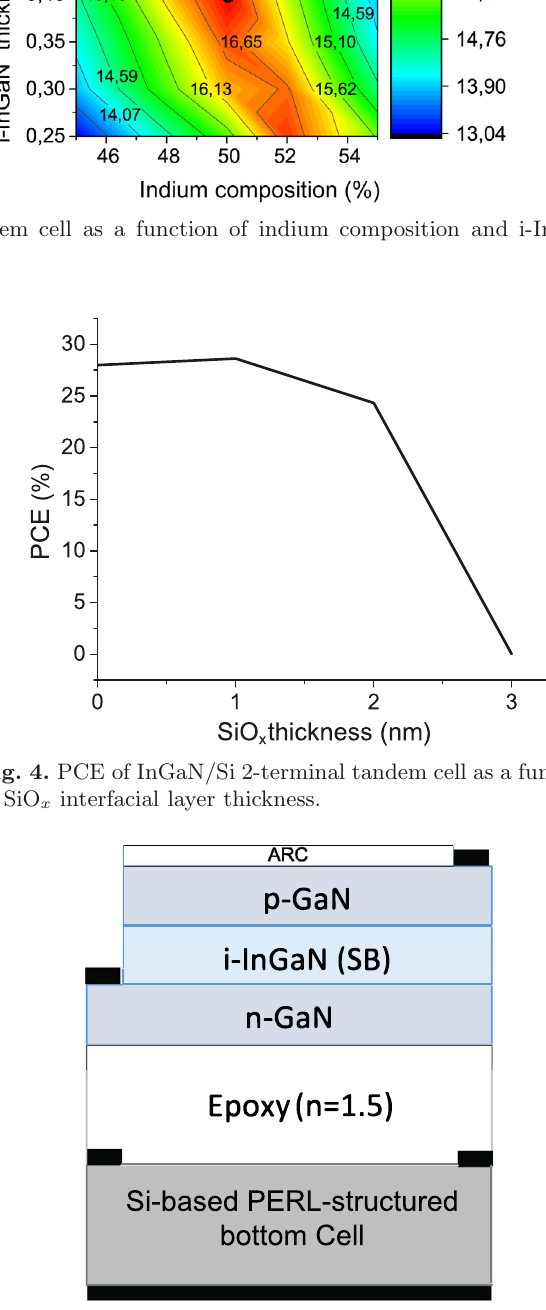
Fig. 5. Modeled structure of InGaN/Si 4-terminal tandem